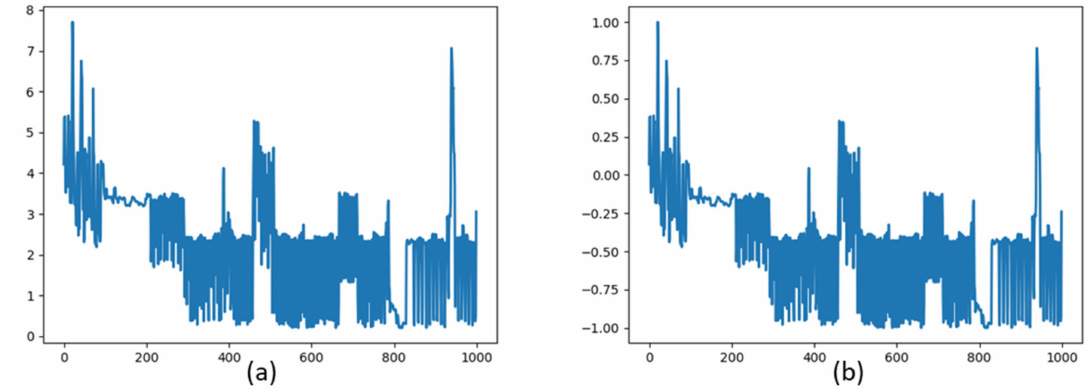
Figure 2. Household Dataset representation ( a ) before and ( b ) after the preprocessing